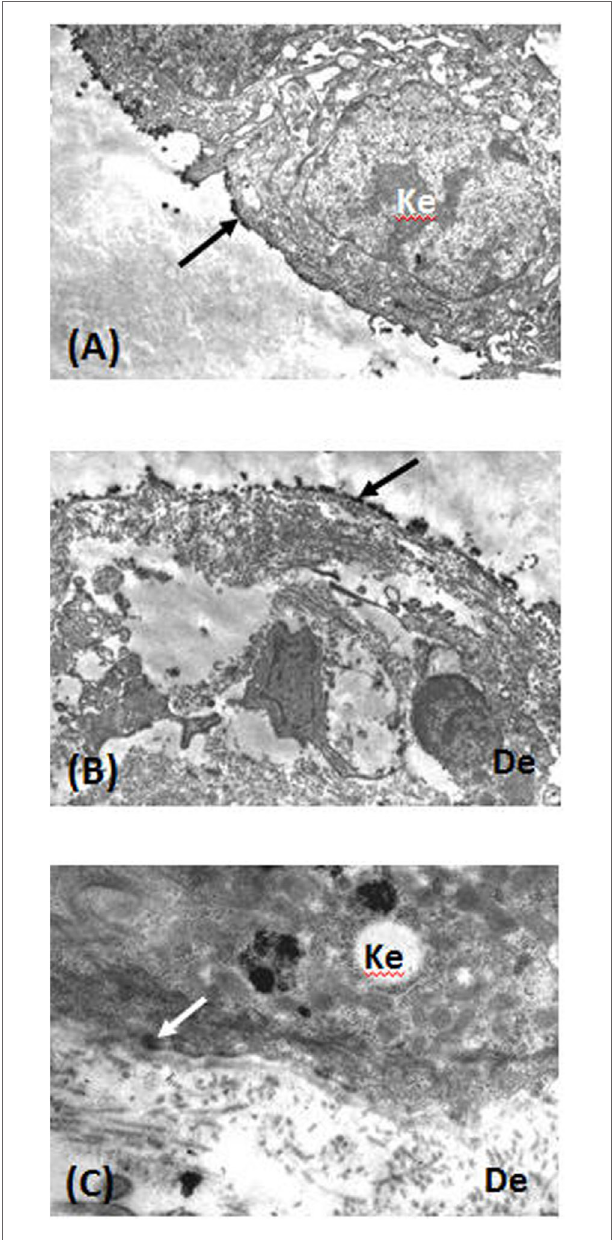
FigUre 4 | Direct immunoelectron microscopy of tissue sections from patients 10 (a,b) and 8 (c) was performed as previously described (37). (a) Immune deposits (arrow) on the lamina lucida (LL) cleavage roof. (b) Immune deposits (arrow) in the lower LL and lamina densa at the cleavage floor. (c) Immune deposits (arrow) in the upper LL, close to hemidesmosomes. Abbreviations: Ke, keratinocyte; De, dermis.